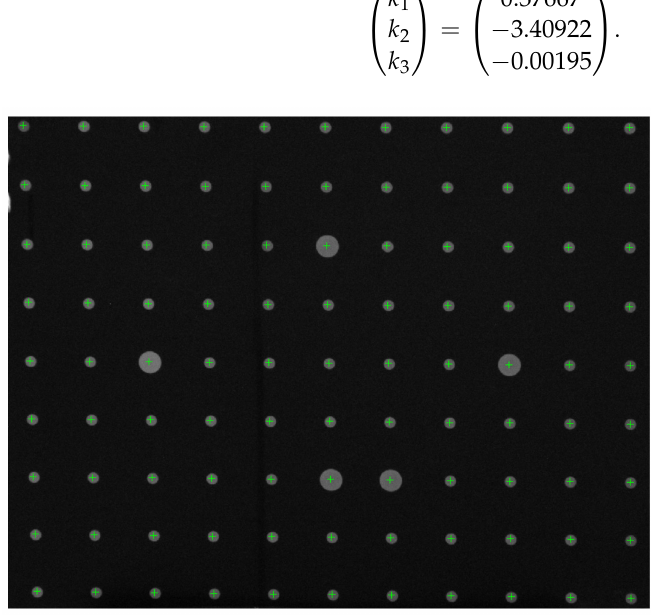
Figure 8. Distortion test of imaging lens